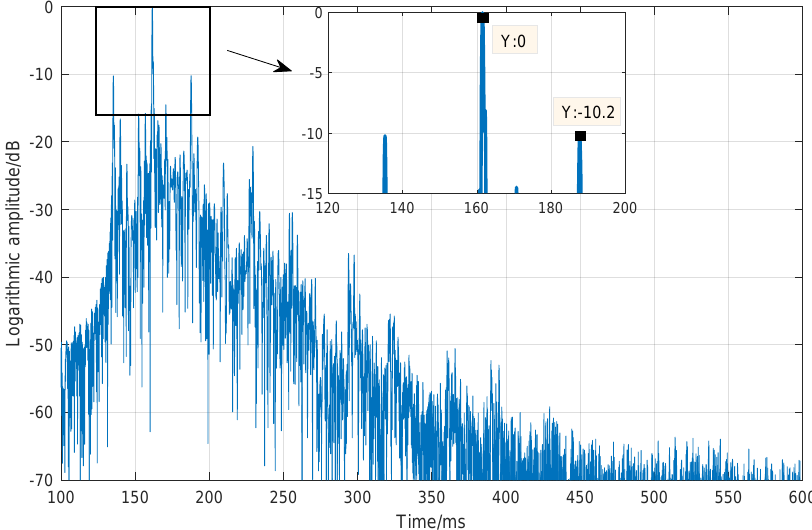
Figure 12. The waveform of received signal processed by TR with lake experiments data.